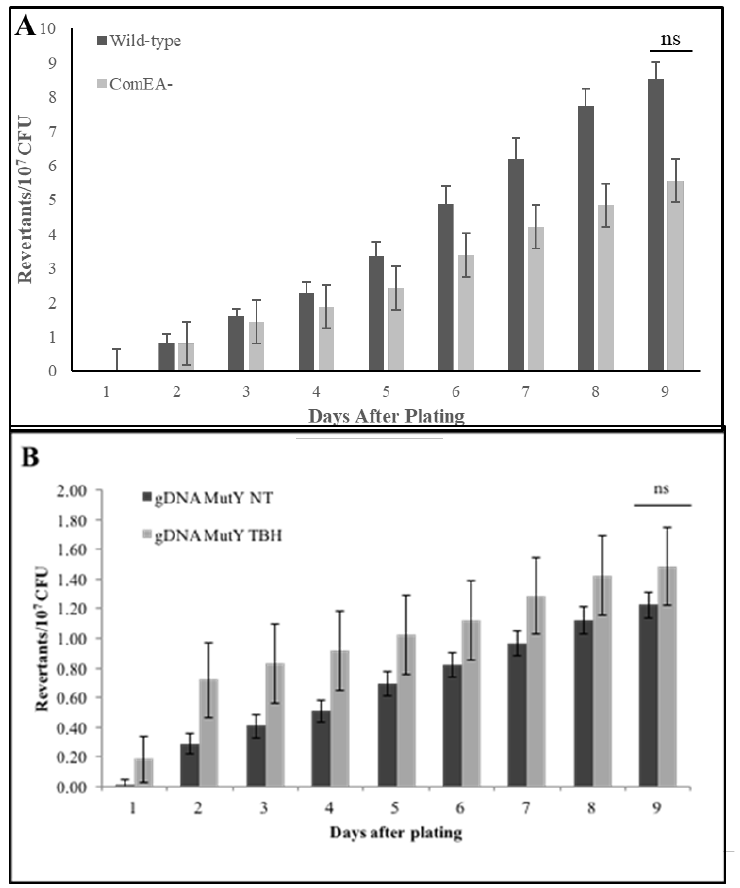
Figure 1. Stationary-phase mutagenesis is DNA-uptake independent. ( A ) The accumulation of stationary-phase Met + revertants under conditions of amino acid starvation in YB955 (parental strain) and JC101 ( comEA − ). Student’s t -test conducted. ( B ) The accumulation of stationary-phase Met + revertants under conditions of amino acid starvation in YB955 after being supplied with DNA that was not treated (NT) or treated with tert -butyl hydroperoxide (TBH) before the DNA was isolated. Data represent the average of at least three separate tests ± standard error of the mean (SEM); ns denotes no significant differences between strains.